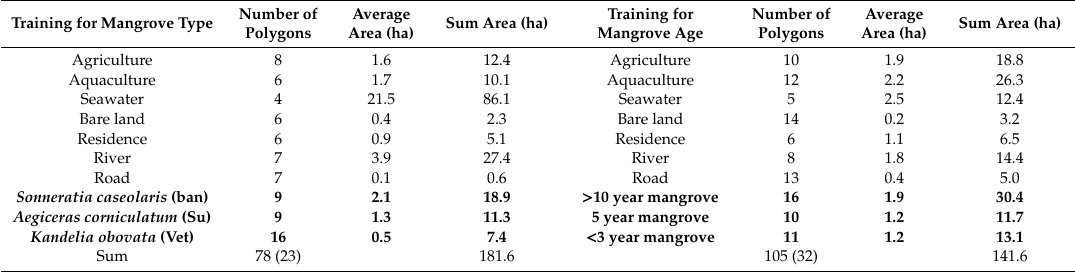
Table 1. In situ data for supervised remote sensing image classifications and accuracy evaluation. Examples of three existing mangrove species with scientific names, local names are marked in bold for